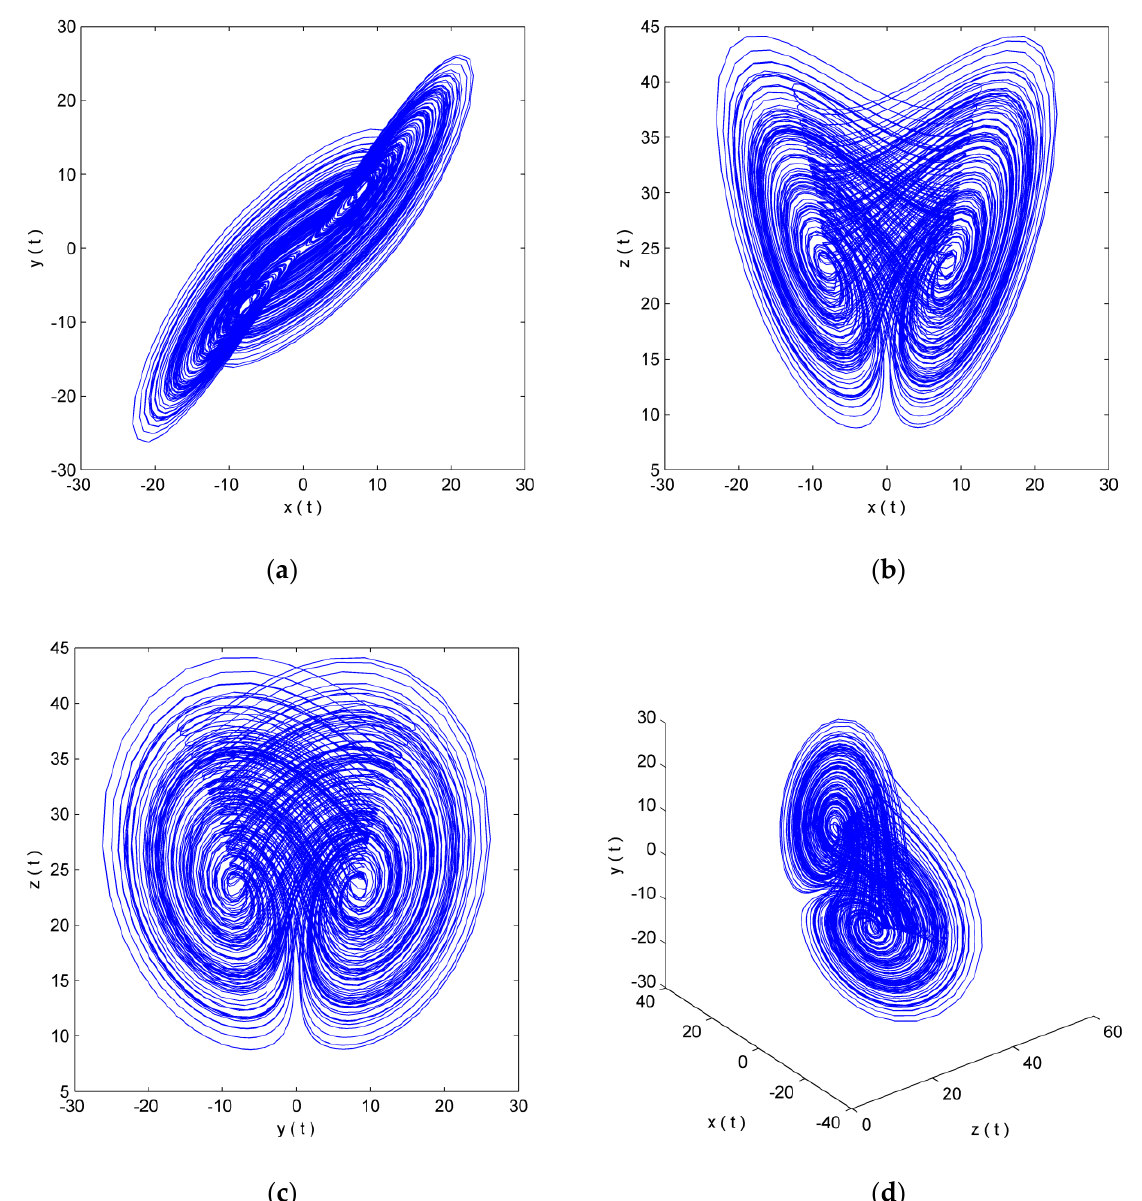
Figure 1. Phase diagram of a three-dimensional chaotic attractor. ( a ) x-y plane phase diagram; ( b ) x-z plane phase diagram; ( c ) x-z plane phase diagram; ( d ) three-dimensional diagram.